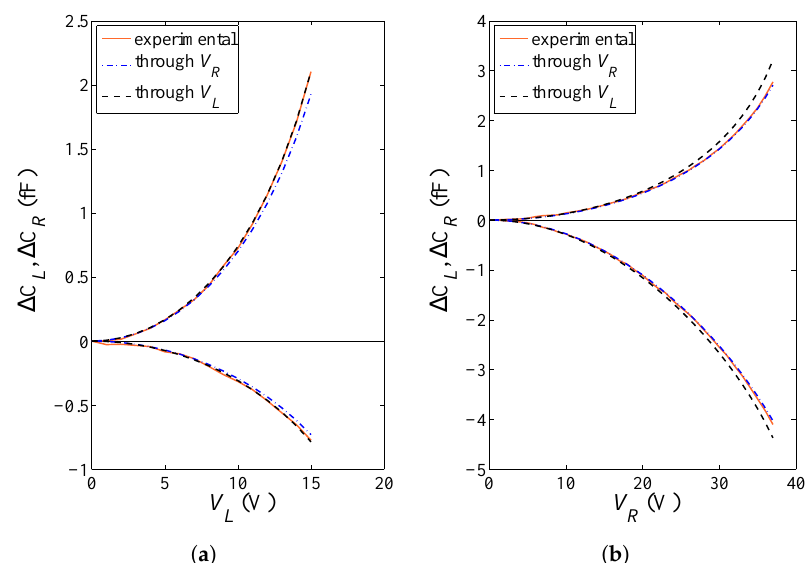
Figure 8. Specimen #4: capacitance change values ∆ C L and ∆ C R under ( a ) lateral actuation through V L and ( b ) rotational actuation through V R . Comparison between the experimentally measured response, and the theoretical solution with model parameters tuned by the GA under either lateral or rotational actuation.